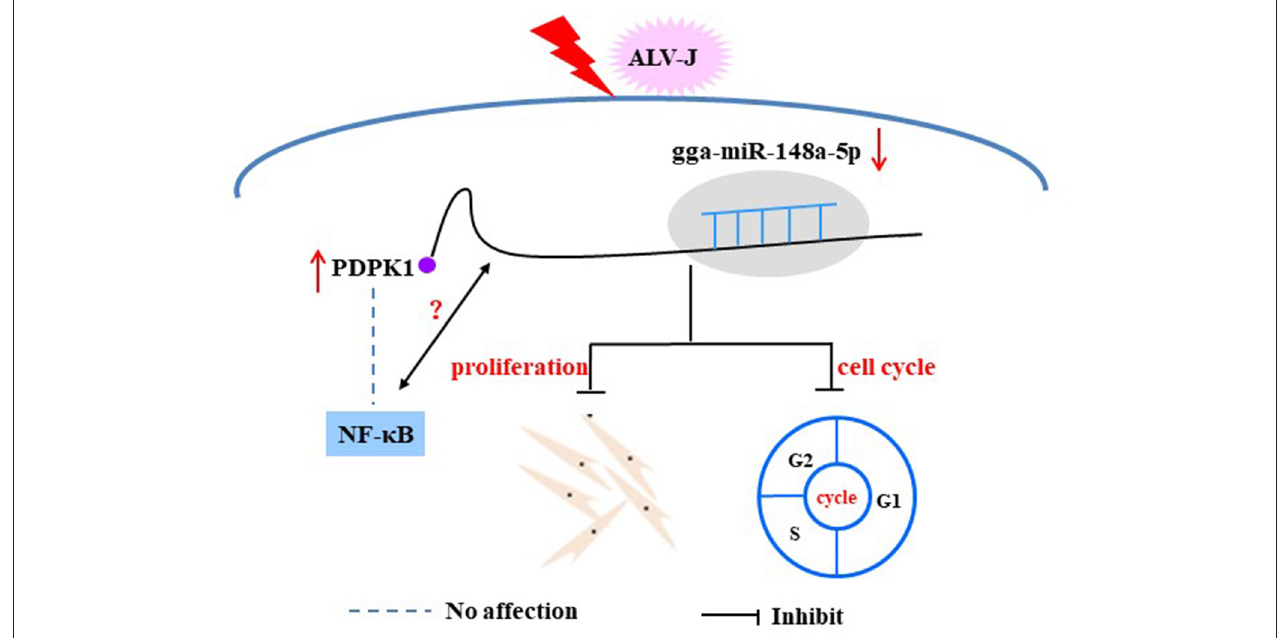
FIGURE 11 | Proposed model of gga-miR-148a-5p regulation on ALV-J-infected CEF cell proliferation and cell cycles.